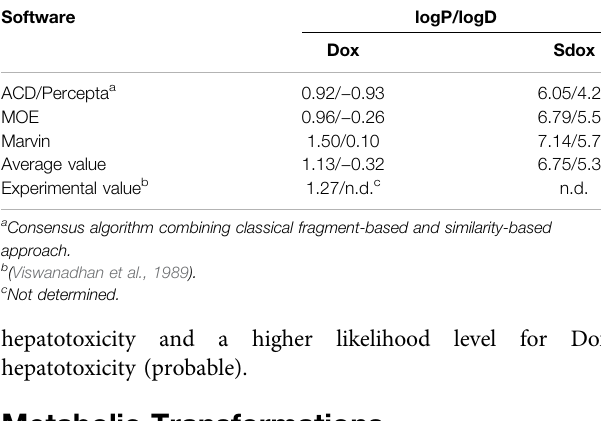
TABLE 1 | Physicochemical pro fi les of Dox and Sdox as predicted by ACD/Percepta software (differences are shaded). Physicochemical parameter